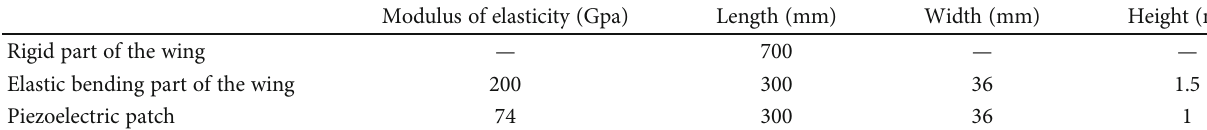
Table 1: Geometric parameters of the wing and the piezoelectric patch.